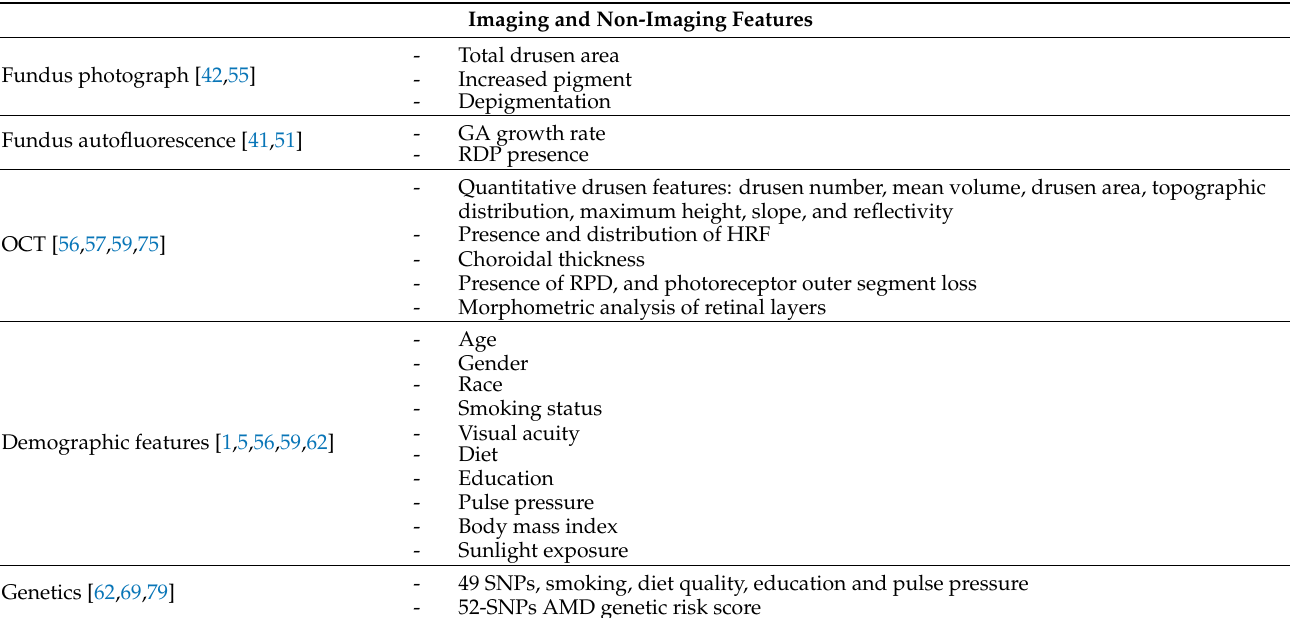
Table 2. Biomarkers considered in artificial intelligence prediction models in age-related macular de-